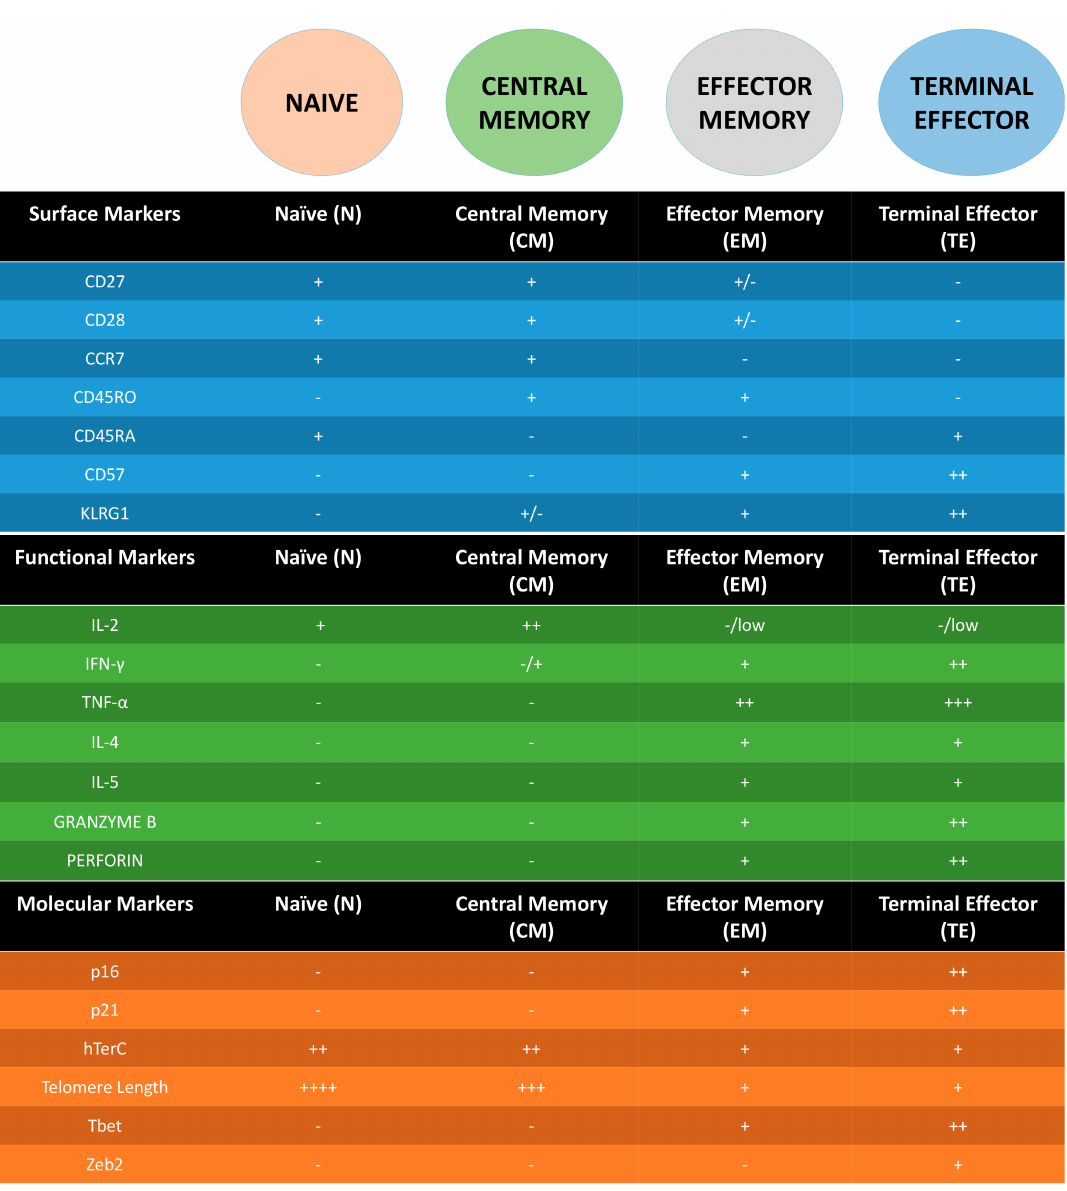
Figure 1. Summary table of surface, functional and molecular markers in the different stages for Adaptive T cells (CD4 and CD8). - = not expressed, + = expressed. Additional + = higher